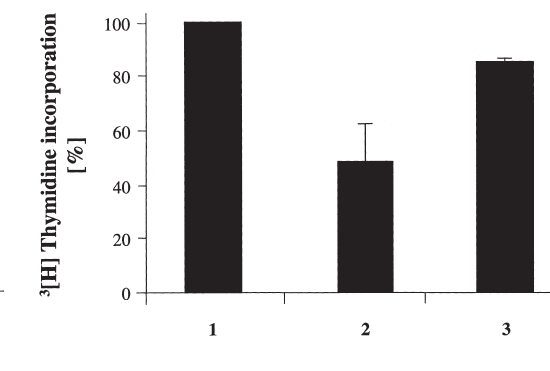
Figure 4 Functional analysis of CIITA promoter IV in response to simvastatin. Plasmid pGL3/461 and a reference plasmid (pRL) were transiently transfected into human vascular ECs. Human ECs unstimulated (1), treated with IFN- γ (500 U/ml; 12 hrs) alone (2), or with simvastatin (10 µ M) (3), or with simvastatin (10 µ M) and L-mevalonate (500 µ M) (4). Results were obtained in independent experiments with ECs from three different donors.